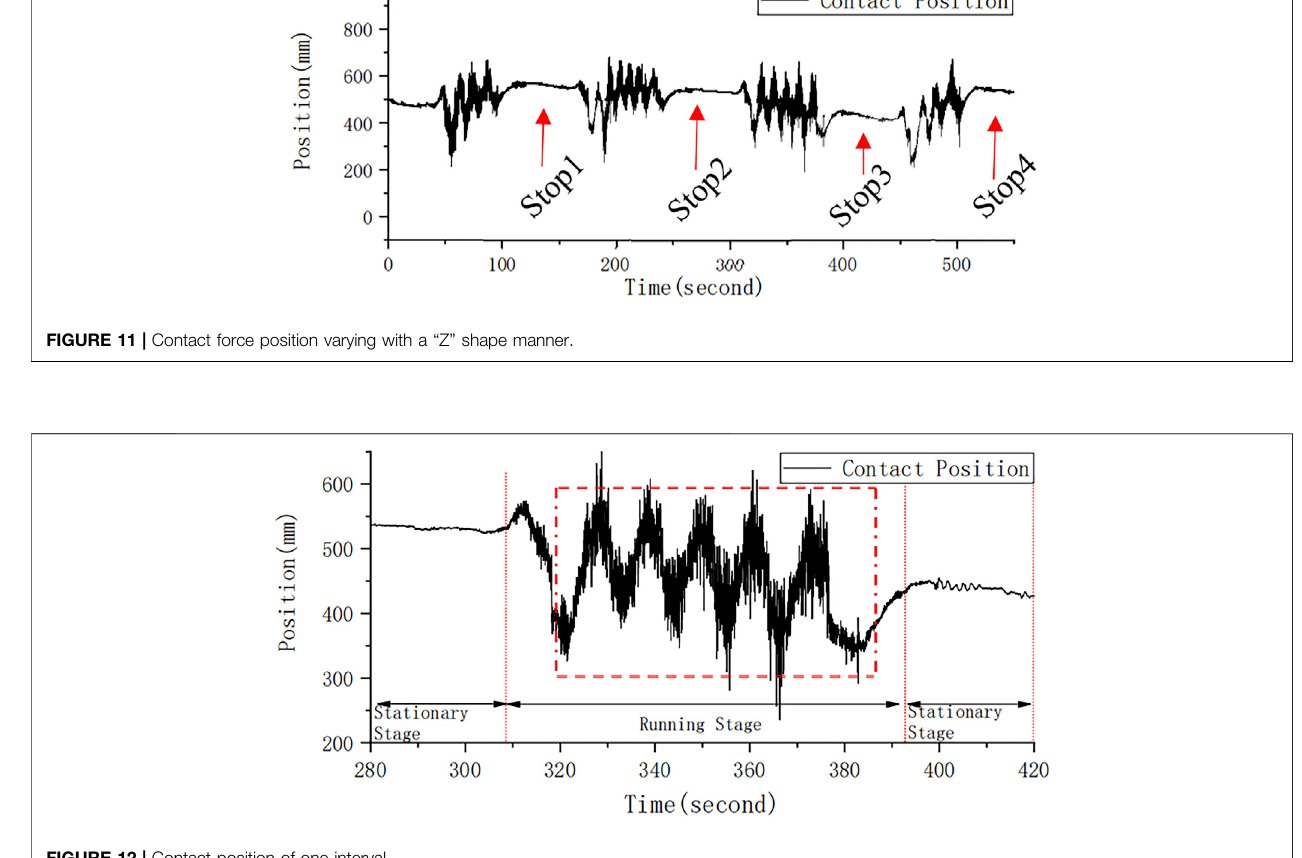
FIGURE 12 | Contact position of one